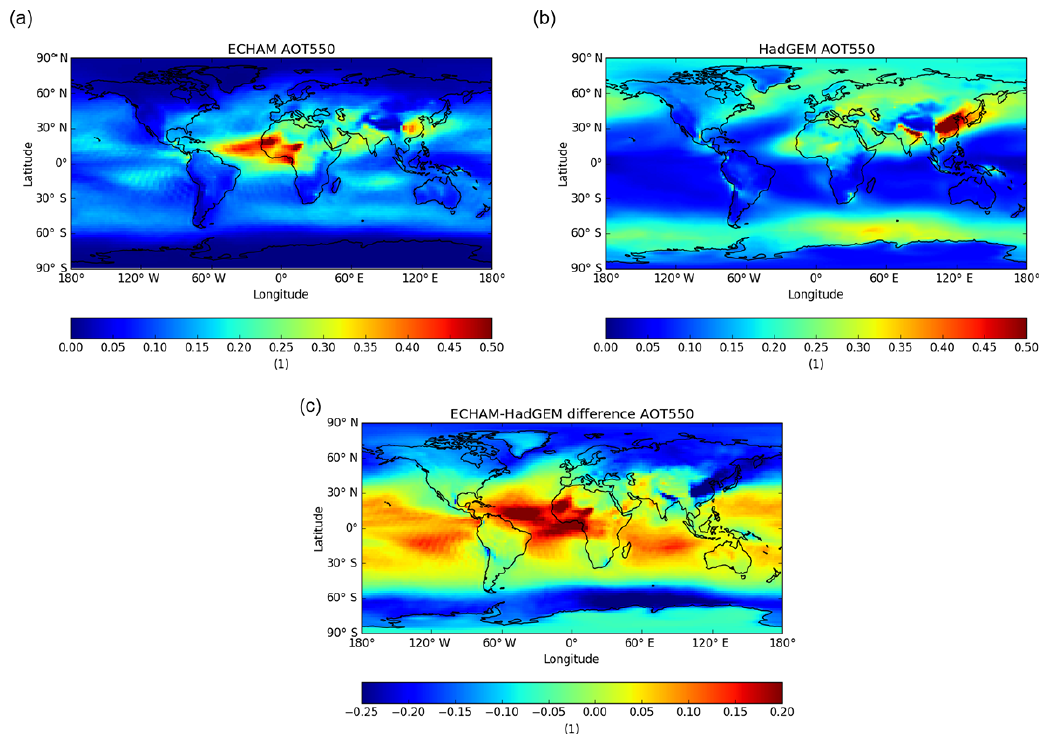
Figure 10. A comparison of annual average AOT at 550nm between ECHAM and HadGEM3 across the globe.